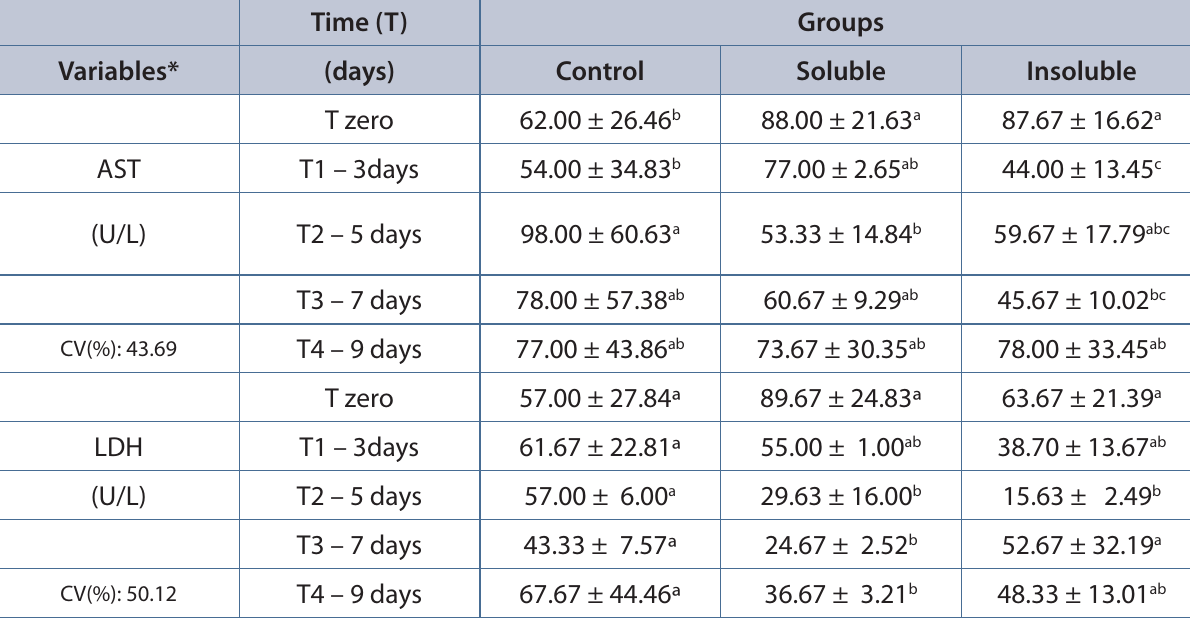
Table 1. Mean serum values of aspartate aminotransferase (AST – U/L) and lactate dehydrogenase (LDH – U/L) in rabbits submitted to gavage with ultra-pure water (CG), water-soluble A. rigida extract (SG) and water-insoluble A. rigida extract (IG) at different times Time